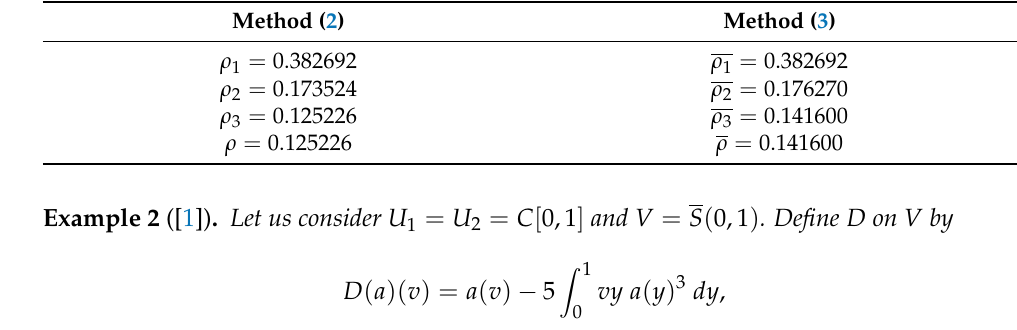
Table 1. Comparison of convergence radii for Example